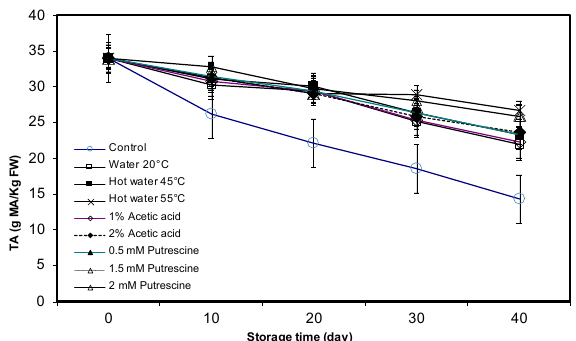
Figure 5. Mean titratable acidity (TA; ± standard deviation; n = 3) of the cv. Shahrodi apricots before and during storage for 40 d at 5°C following different